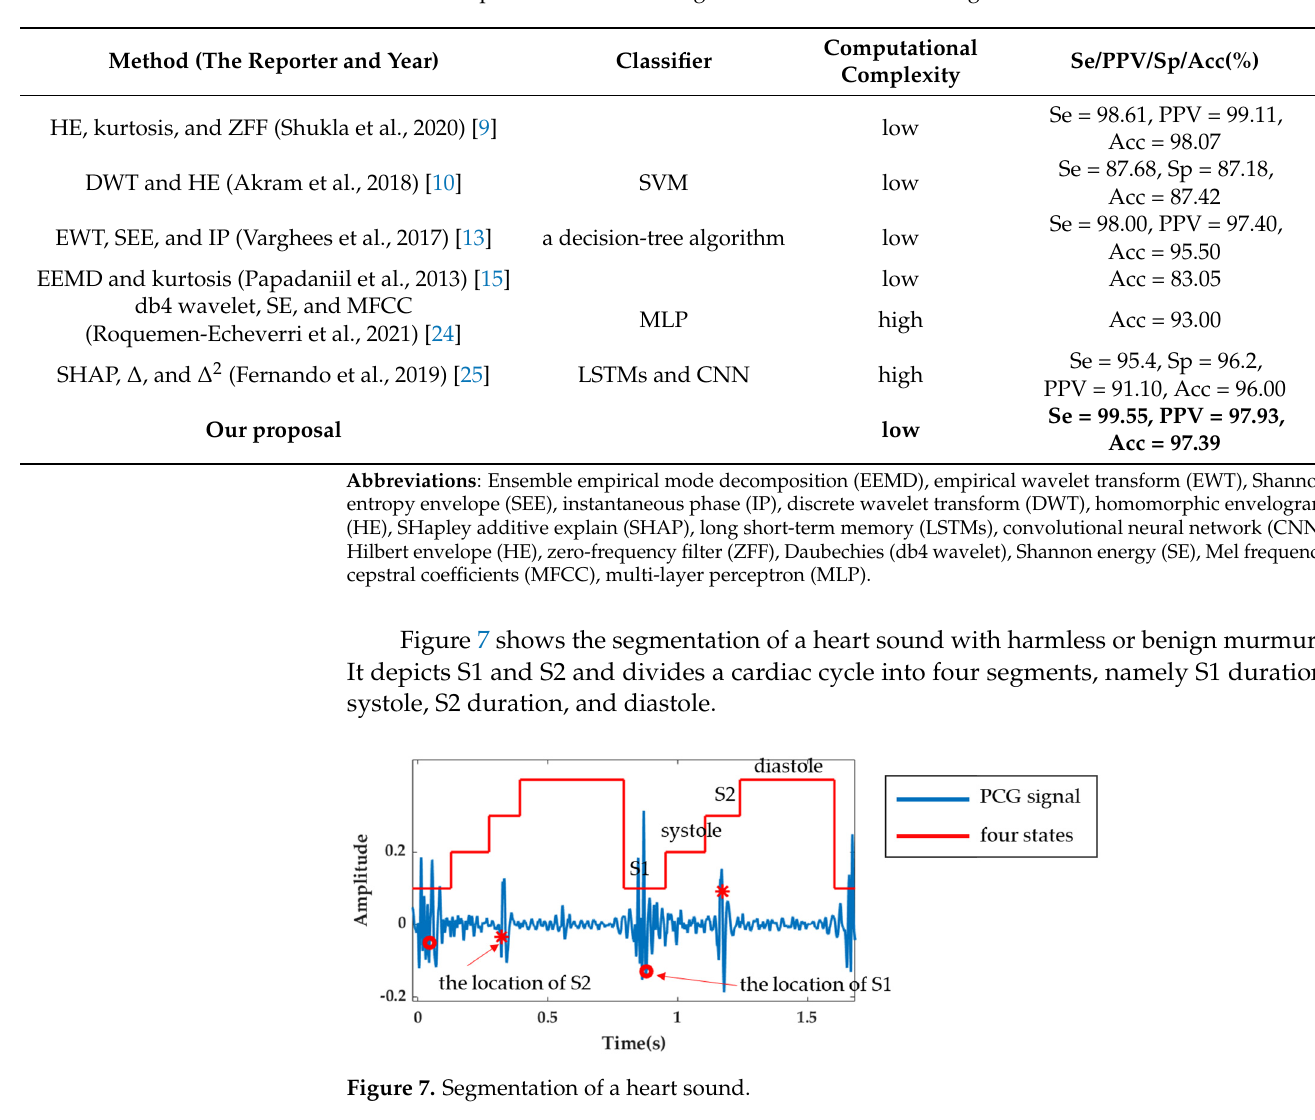
Table 2. Comparison of different algorithms for heart sound segmentation.